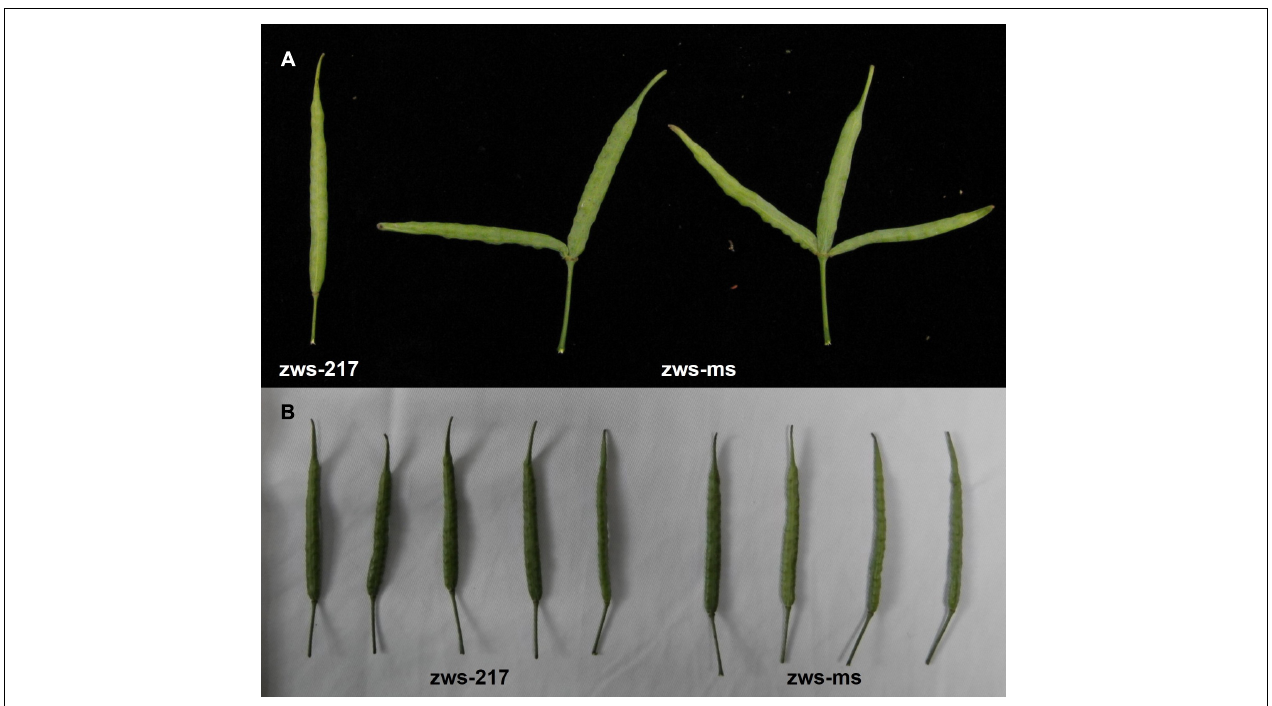
FIGURE 1 | Multi-silique phenotype in zws-ms. (A) Compared with normal silique in its near-isogenic line (NIL) zws-217, zws-ms had three individual siliques sharing one carpopodium in Xindu. Sometimes, one of silique degrade. (B) Both zws-ms and zws-217 showed normal siliques in colder Ma’erkang.